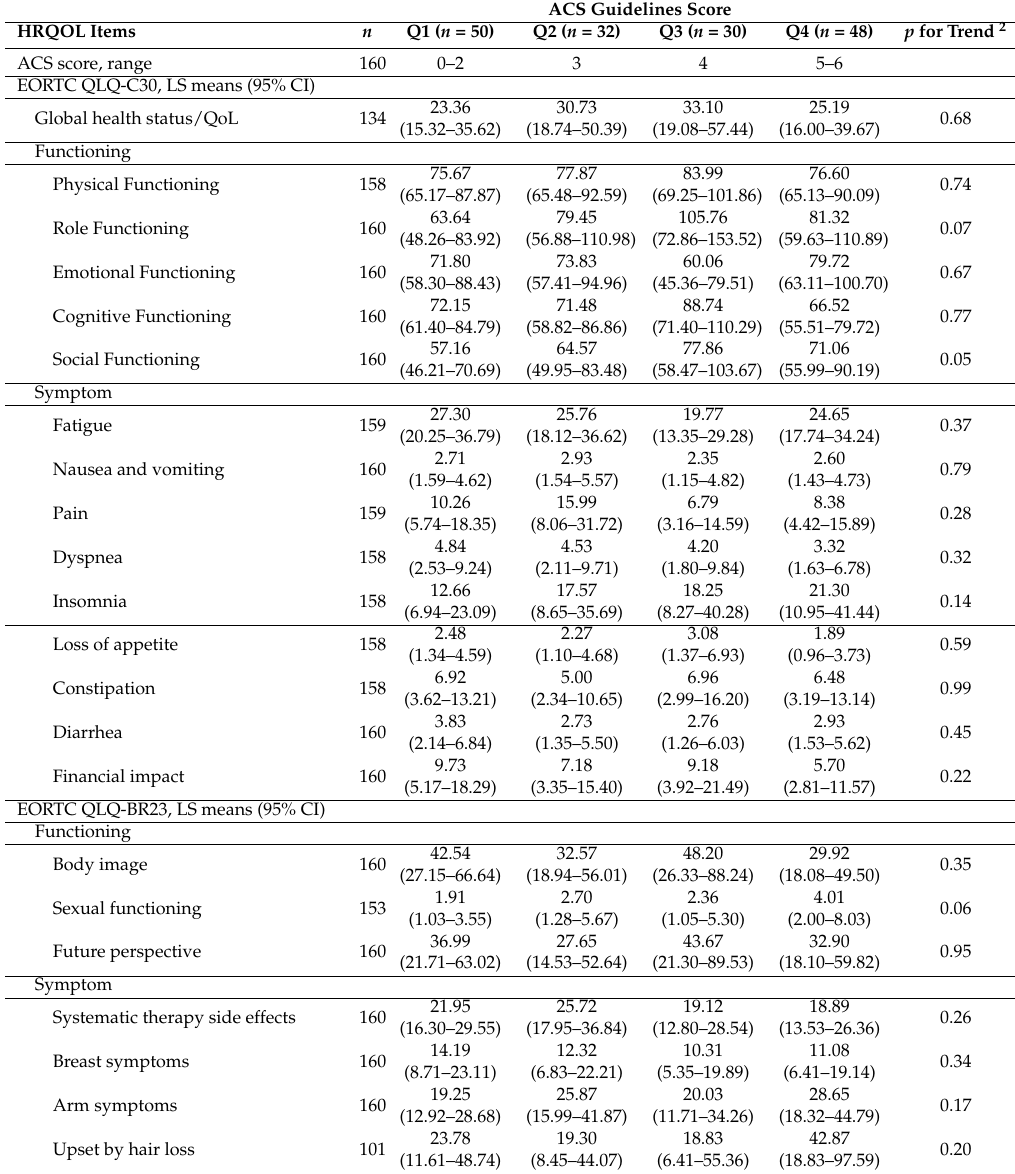
Table 4. Health-related quality of life (HRQoL) scores according to ACS guidelines adherence score among breast cancer survivors with stage I to III ( n = 160) 1